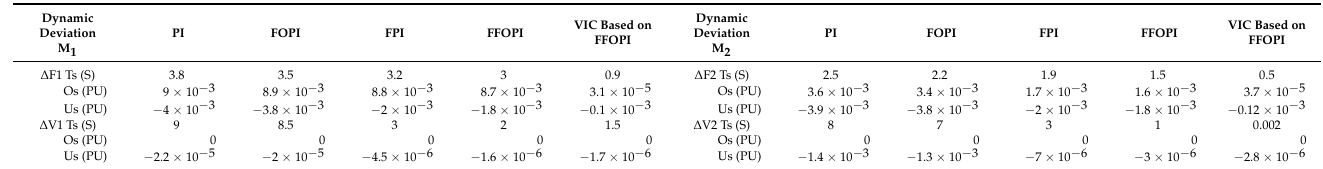
Table 14. Dynamic specification of frequencies and voltage deviation for each controller at discon- necting tie